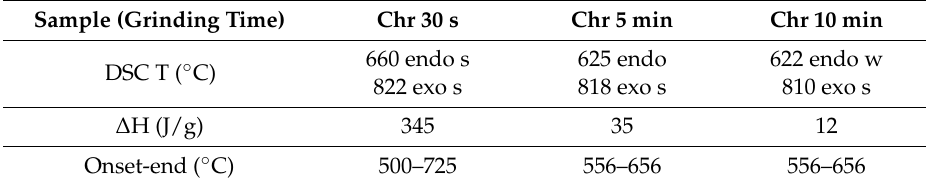
Table 1. Main peak temperatures in DSC curves and ∆ H dehy for chrysotile (Chr) ground for 30 s, 5 min and 10 min, w = weak, s = strong, endo = endothermic, exo = exothermic. The area under the endothermic peak ( ∆ H dehy ) is delimited in the range onset-end.